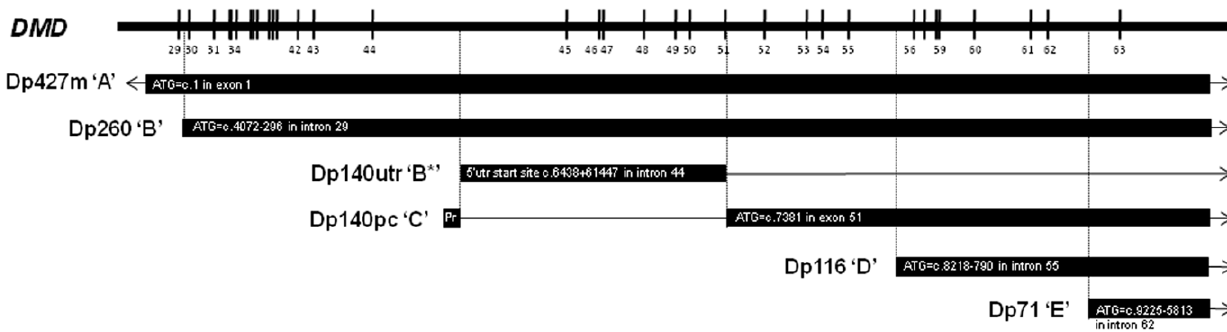
Figure 1. Genomic organisation of alternate dystrophin isoforms. The relationship between the abbreviated nomenclature used for the isoforms affected by a DMD mutation and the structure of the Dp427m, Dp260, Dp140 and Dp116 isoforms of the dystrophin gene. The black vertical lines represent the coding exons of the dystrophin gene with exon numbers given below. The positions of the initiator Methionine (ATG), untranslated region start site (utr) and promoter (Pr) are depicted. The figure demonstrates that exons 45–50 together with the 5 9 region of exon 51 lie within the 1.041Kbp 5 9 UTR of Dp140 as well as within the coding regions of Dp260 and Dp427. The numbering used is with respect to intron/exon structure of Dp427m NM_004006.2 and the Human Genome reference sequence of Ensembl build 52 (Dec 2008) implemented in Alamut version